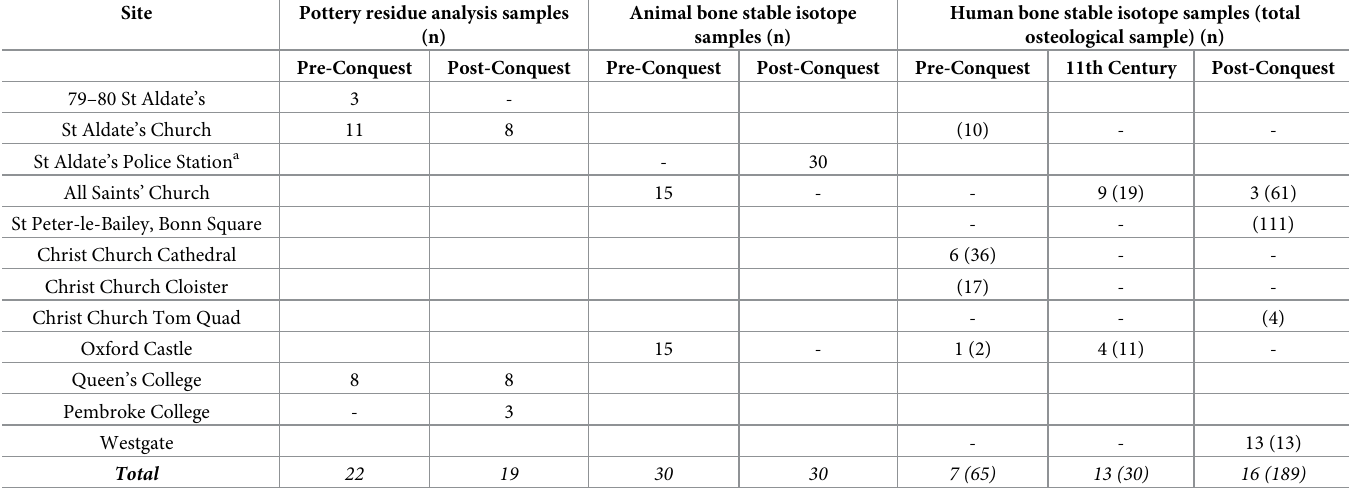
Table 1. Pottery, animal bone and human bone samples included in the present